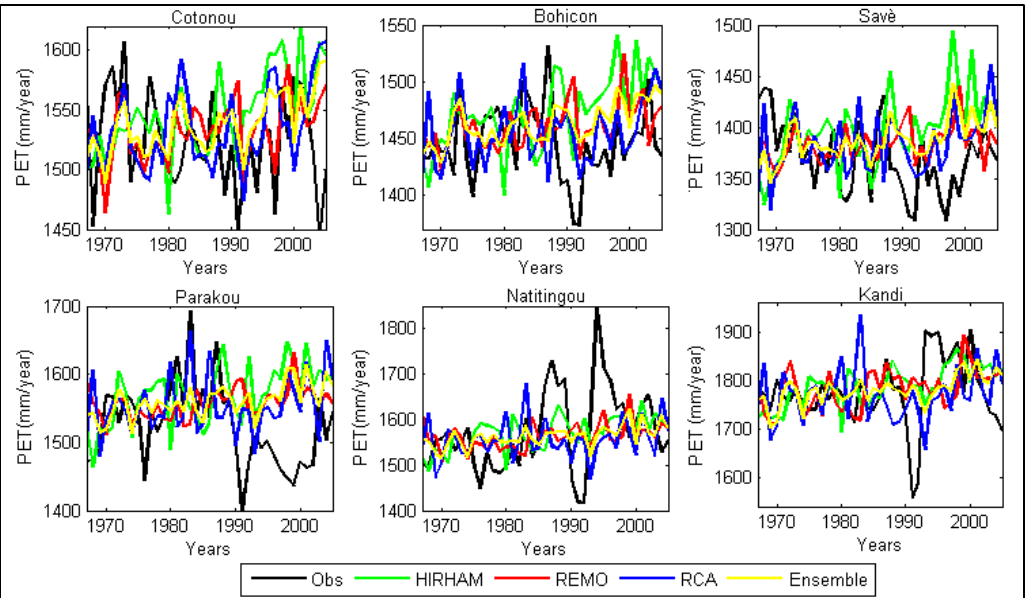
Figure 4. Observed and simulated (bias corrected with EQM method) annual PET.